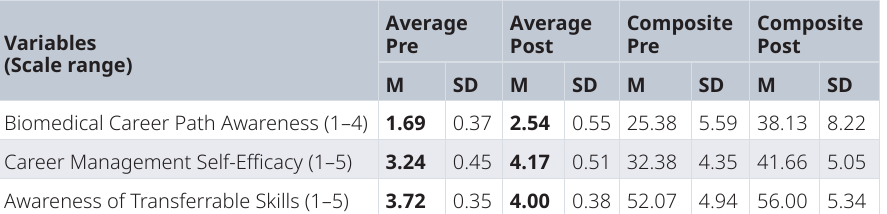
Table 3. Pre- and post-course composite variable means and standard deviations (PSP). Career readiness composite variable summaries pre- and post-course participation (means and standard